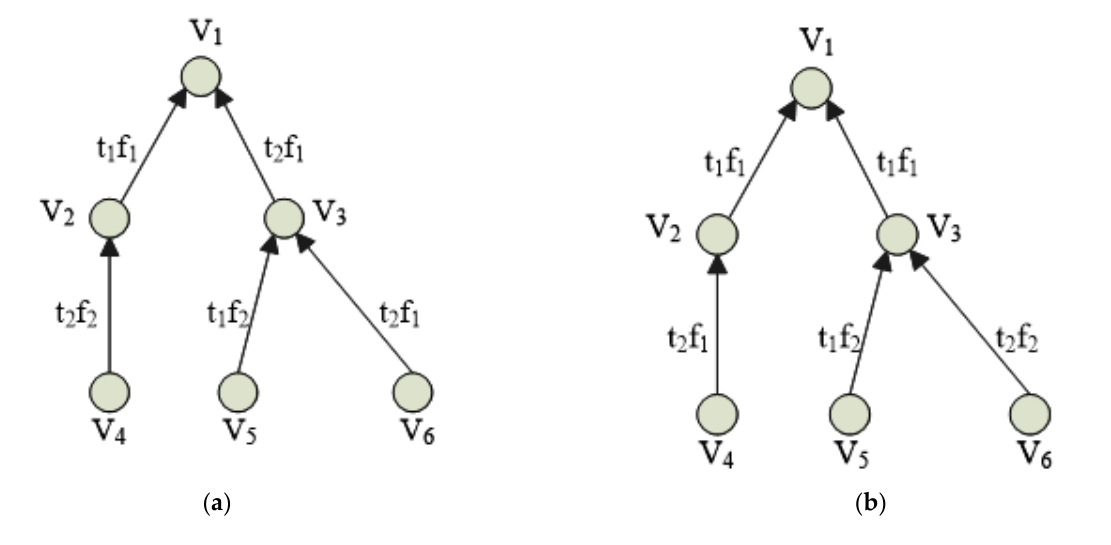
Figure 6. Effects of scheduling channels and time slots on numbers of communication conflicts. ( a ) 2 communication conflicts, ( b ) 5 communication conflicts.